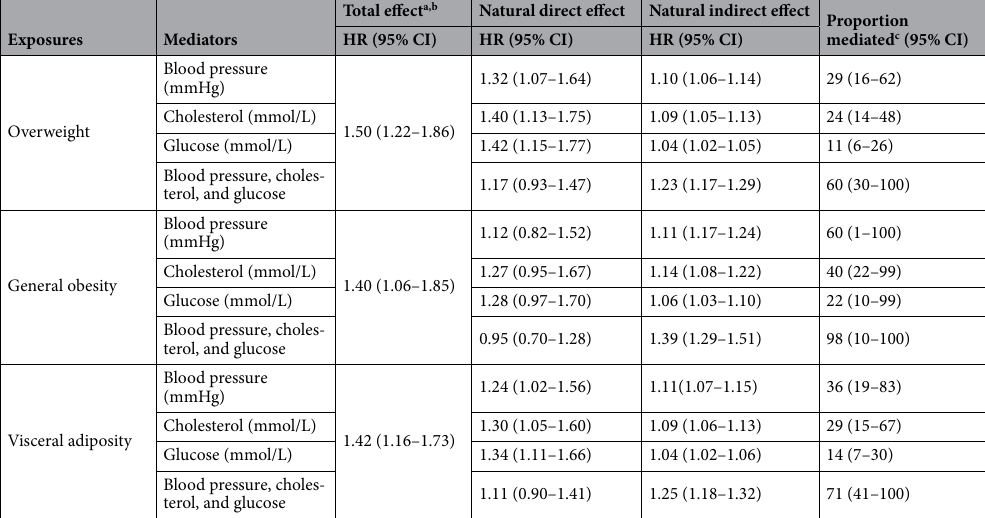
Table 3. Total, direct, and indirect effects of overweight and adiposity on cardiovascular diseases (CVDs) using a parametric method not considering exposure-mediator interaction in men. MI body mass index; CI confidence interval; HR hazard ratio; WC waist circumference. a Compared with normal-weight participants for general adiposity and WC < 90 cm as a reference for central adiposity. b All models were adjusted for age, gender, smoking, physical activity level, educational status, and family history of CVDs. c The direct, indirect, and total effects were estimated for each bootstrap